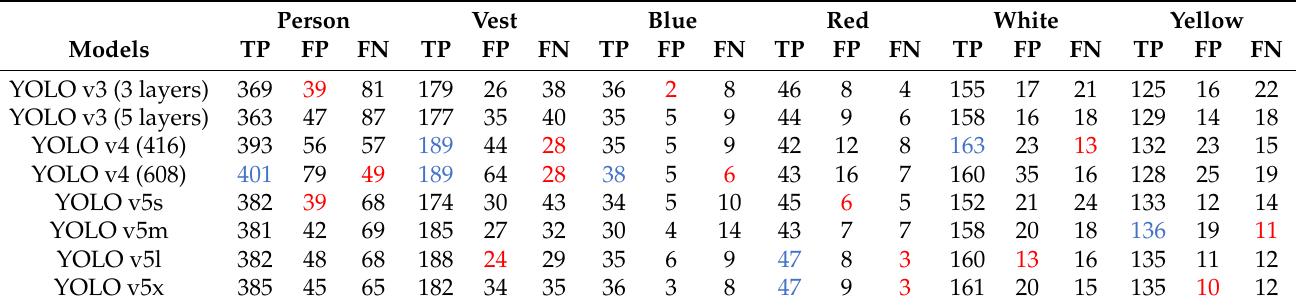
Figure 11. Wrong detections in YOLO v5x. Table 8. Confusion matrix of YOLO